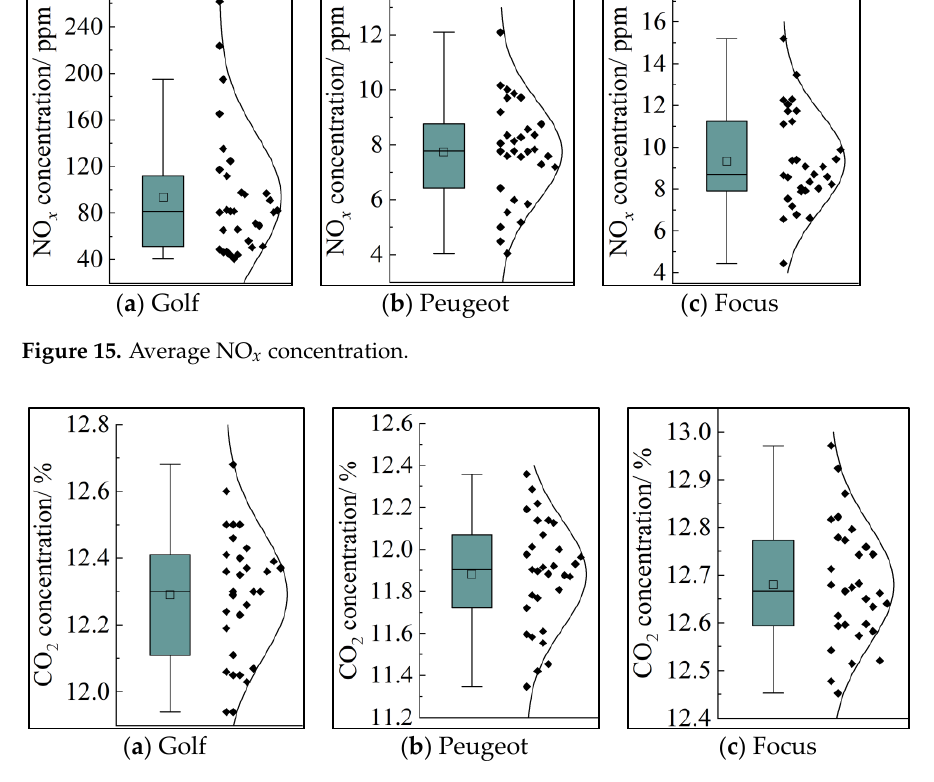
Figure 15. Average NO x concentration.